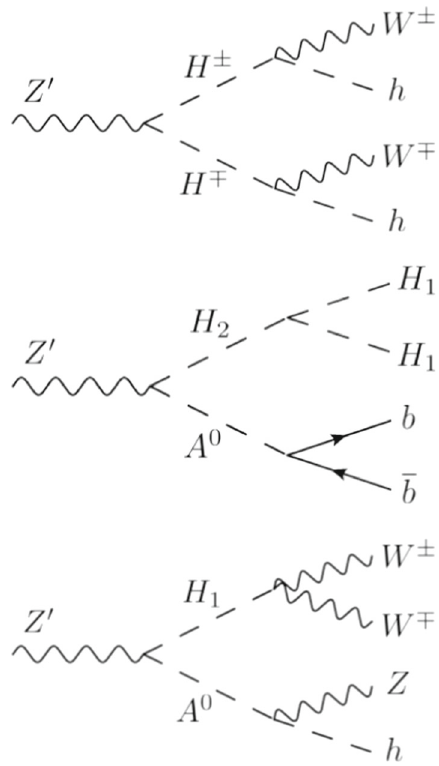
Fig. 1 Feynman diagrams for the Z (cid:2) cascade decays studied in each benchmark scenario